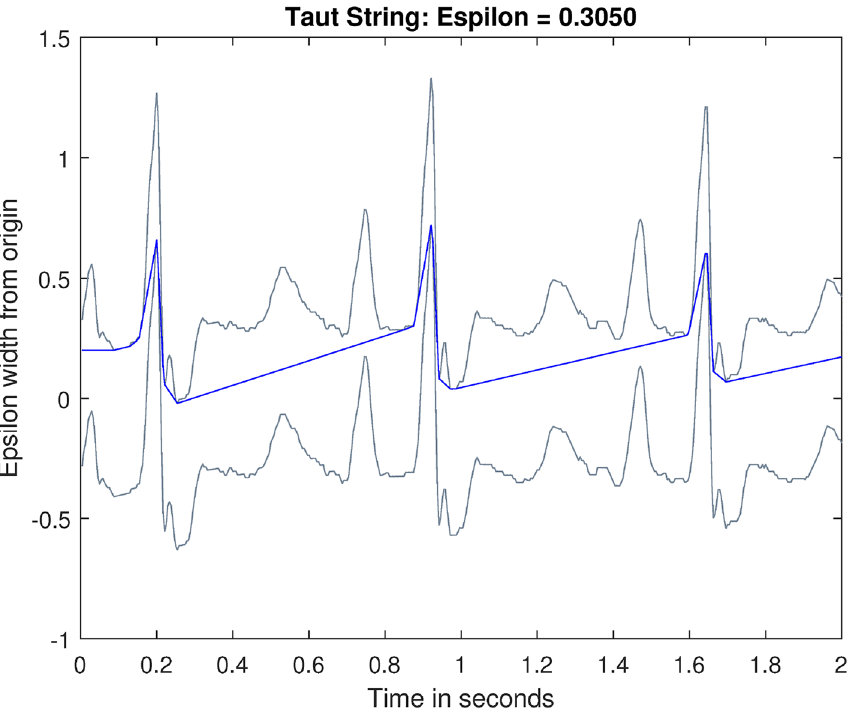
Figure 2. TS Approximation of ECG Signal. The grey waveforms are the margins for TS, f + ǫ and f − ǫ , the blue line is the TS estimation.